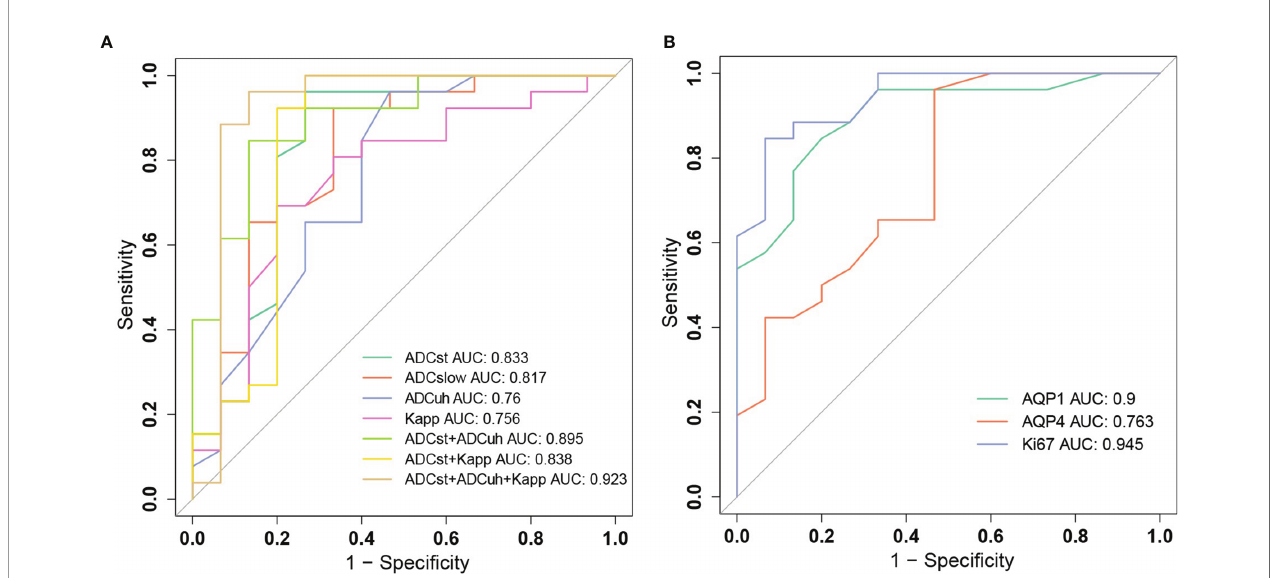
FIGURE 5 | Receiver operating characteristic (ROC) curves for grading gliomas. (A) ROC curves of diffusion weighted imaging (DWI) parameters ADC st , ADC slow , ADC uh , K app and their combinations. (B) ROC curves of histological biomarkers of AQP1, AQP4 and